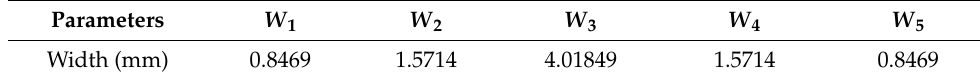
Table 3. Actual width of modulated magnetic pole under one